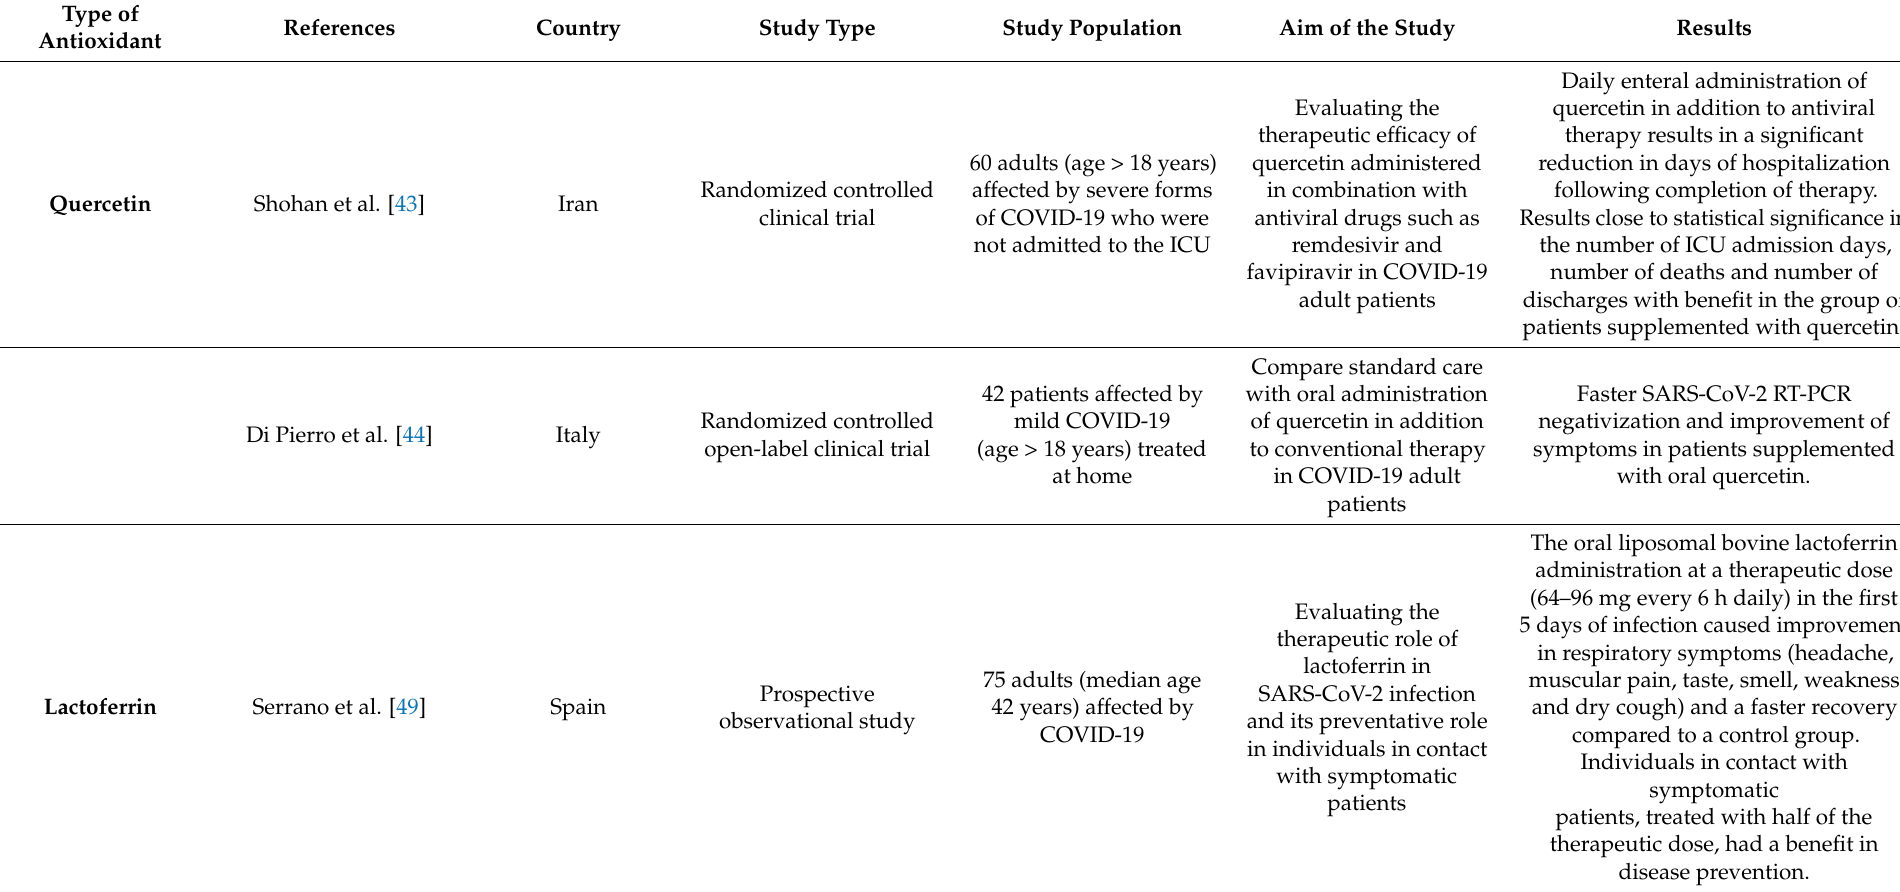
Table 2. Potential clinical use of antioxidants in prophylaxis and/or treatment of SARS-CoV-2 infection in